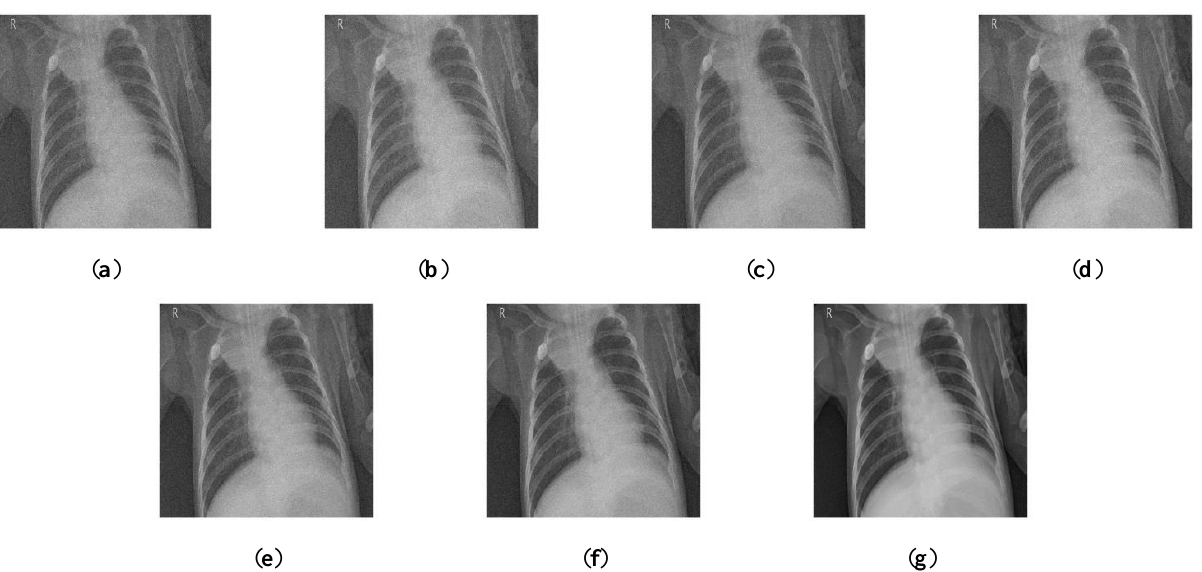
Figure 8. Results of CT image denoising, ( a ) Outcomes of Mingliang et al., 2016 [5]; ( b ) outcomes of Kuppusamy et al., 2019 [7]; ( c ) outcomes of Cheng et al., 2019 [10]; ( d ) outcomes of Zhao et al., 2019 [11]; ( e ) outcomes of Jomaa et al., 2018 [13]; ( f ) outcomes of Manoj and Singh, 2020 [14]; ( g ) outcomes of proposed method.